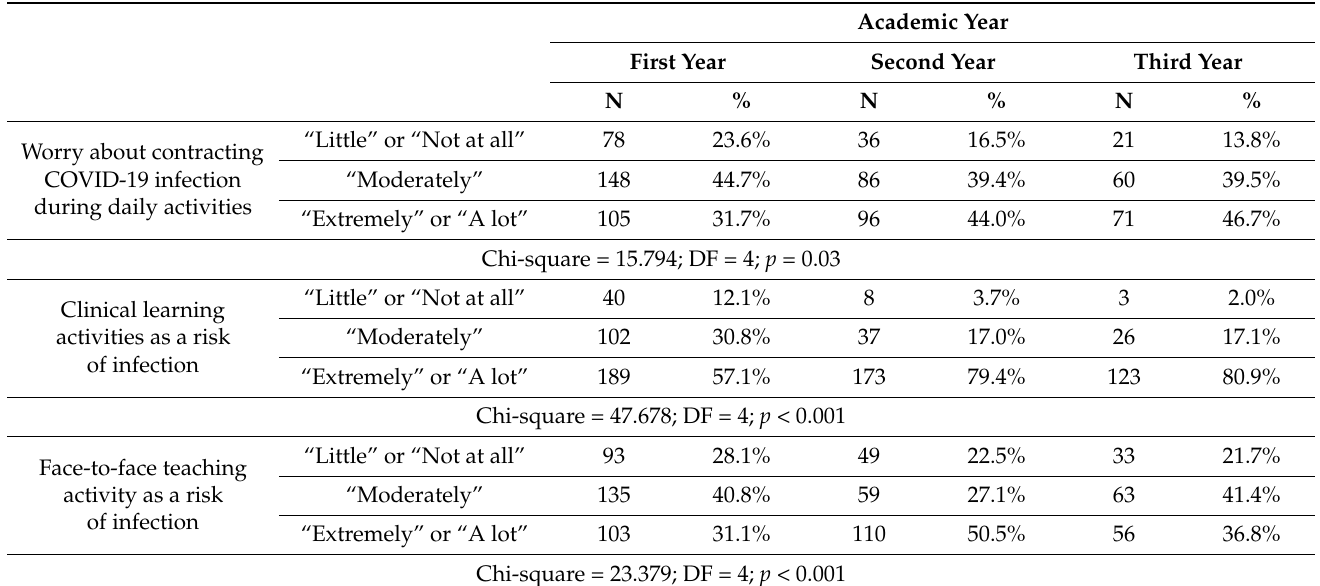
Table 2. Frequency distribution for Academic year about the perceived risk to contract COVID-19.